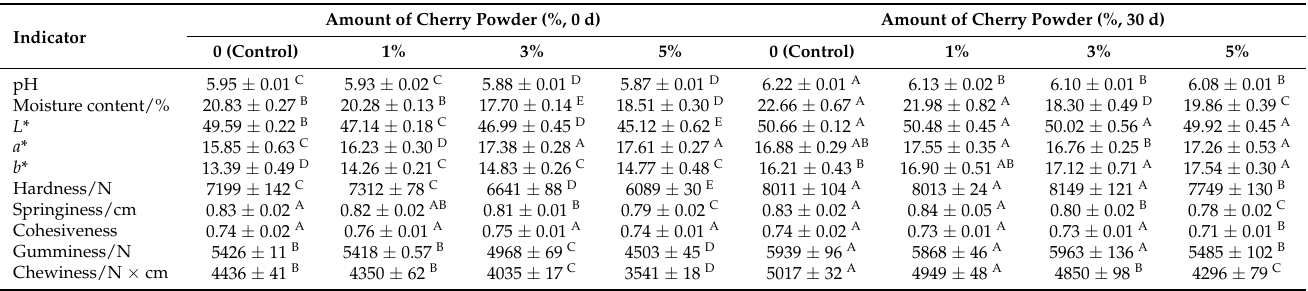
Table 1. Effects of cherry powder addition on the texture properties of Jiangsu-type sausage dur- ing